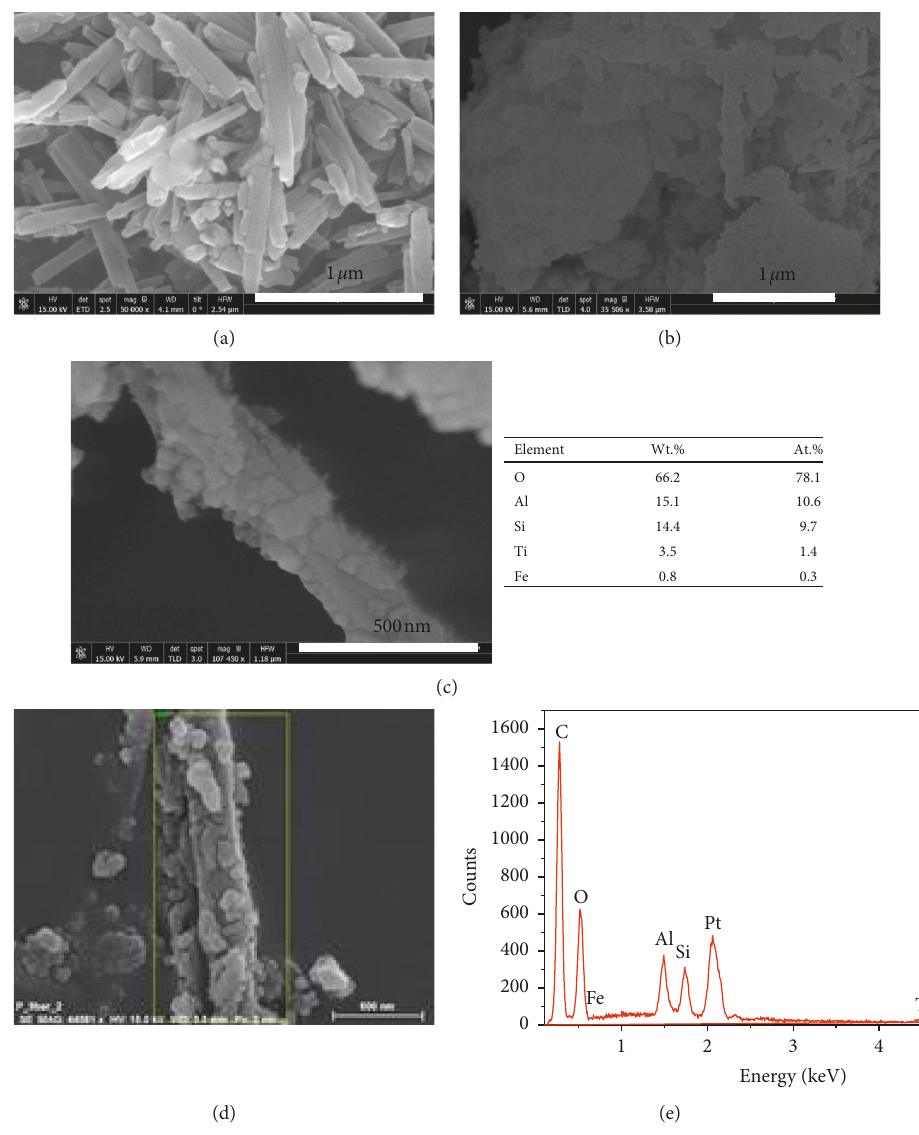
Figure 7: Scanning electron microscopy images of (a) HNTs, (b) TiO 2 -1 wt.% Fe-50 wt.% HNTs at low magnification, (c) TiO 2 -1 wt.% Fe-50 wt.% HNTs at high magnification. (d) The secondary reference image for the area EDX data was acquired (TiO 2 -1 wt.% Fe-50 wt.% HNTs) and (e) EDX spectrum of TiO 2 -1 wt.% Fe-50 wt.%